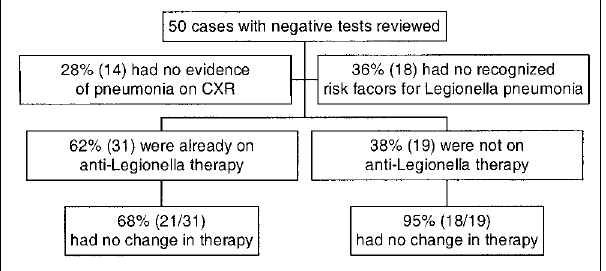
Figure 2) Patients with negative urinary antigen tests. CXR Chest